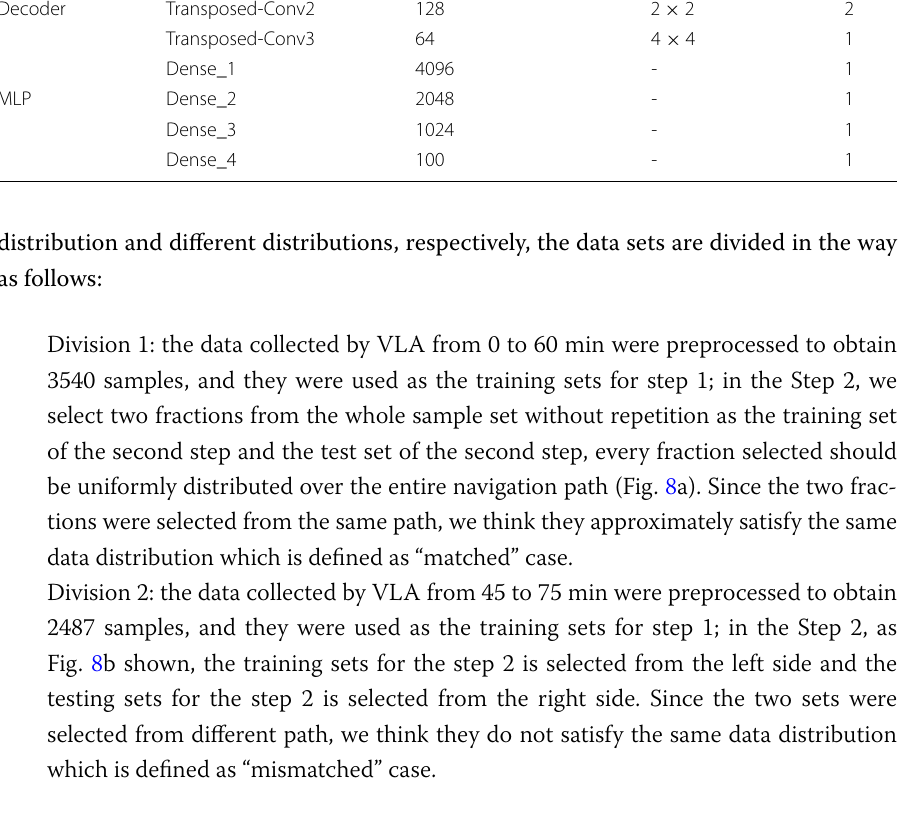
Table 1 Parameters of the network model for each part of the semi-supervised learning underwater acoustic source localization framework